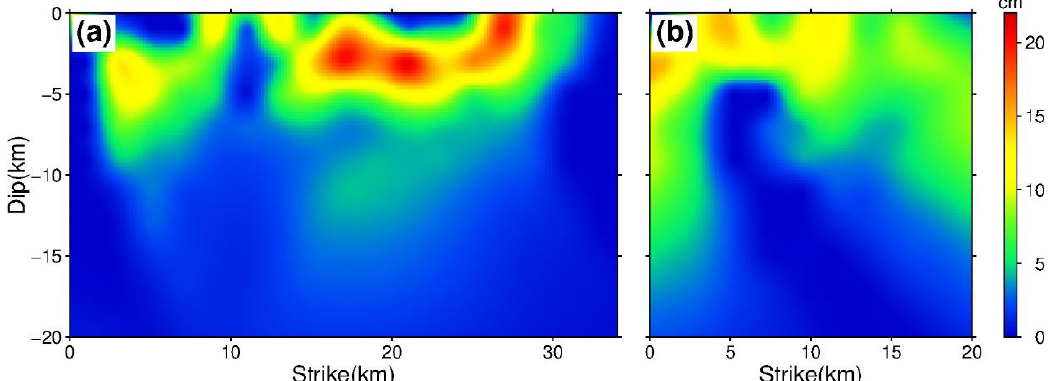
Figure 8. The standard deviations of the ( a ) main fault, and ( b ) secondary fault, based on the bootstrap method.